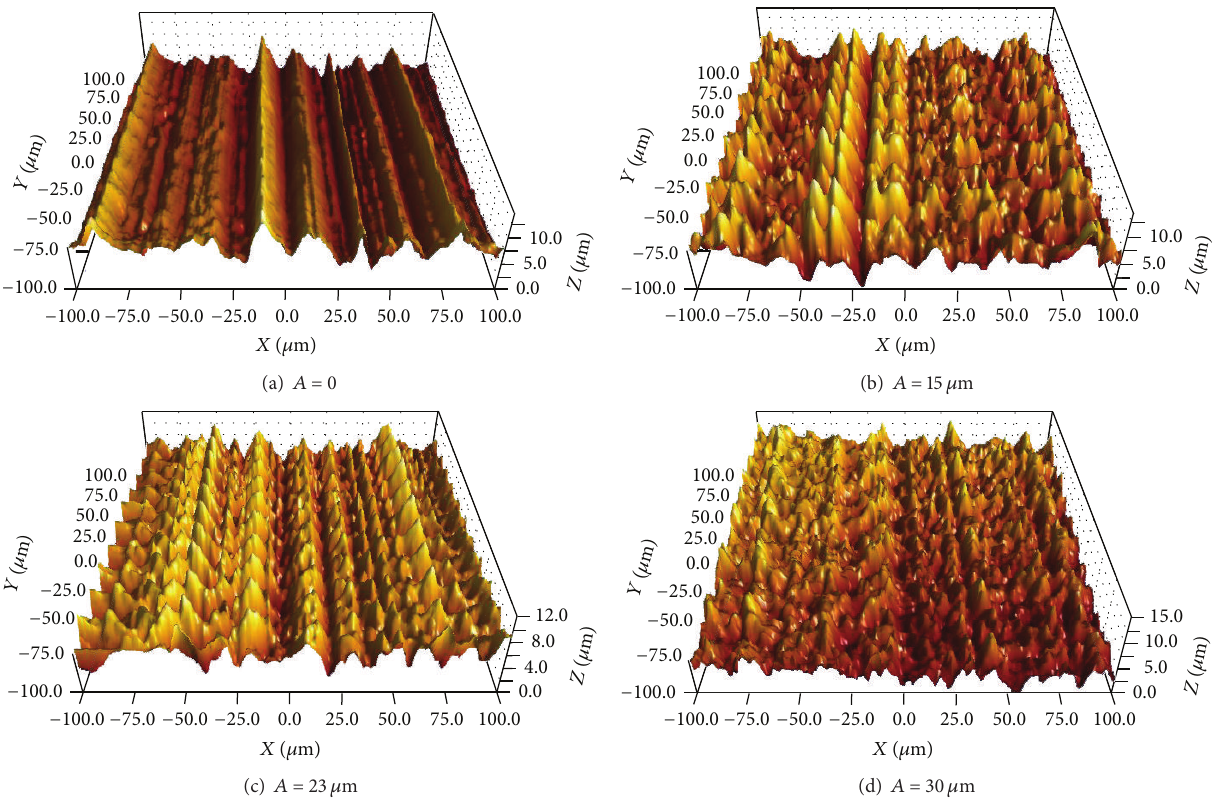
Figure 16: 3D surface topography of machined workpiece under different ultrasonic